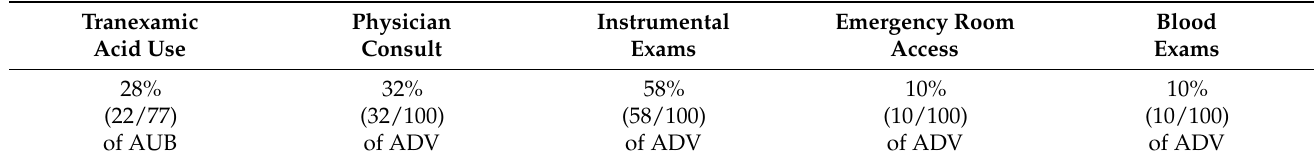
Table 2. Adverse effects-group (ADV) clinic management tools (expressed in percentage, %).